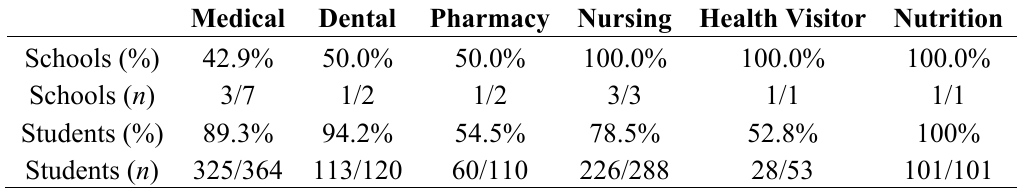
Table 1. Response Rates of Colleges and Third-Year Medical, Dental, Pharmacy, Nursing, Health Visitor and Nutrition Students (Greek Ghpss, 2009).